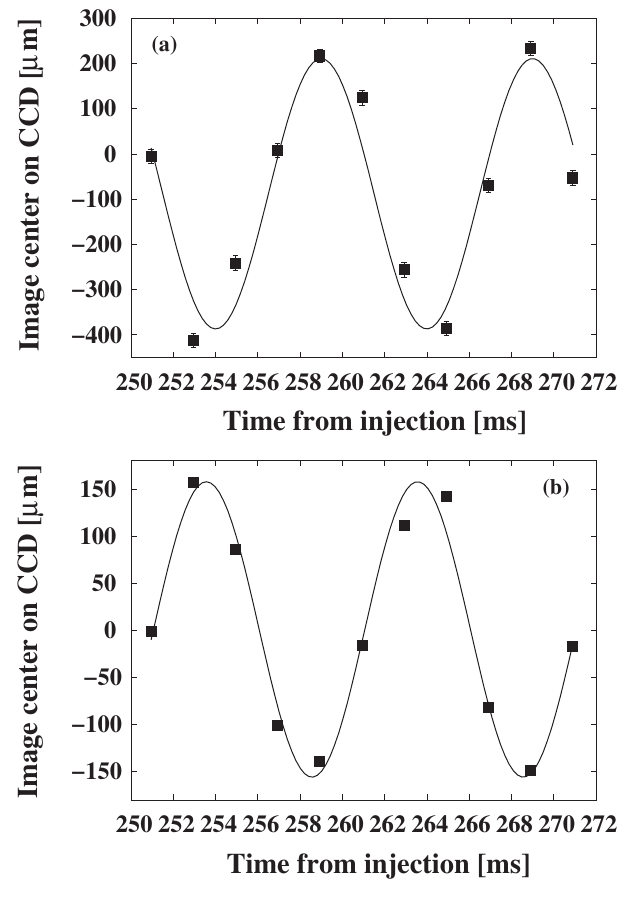
FIG. 13. Dependences of the measured (a) horizontal beam image center and (b) vertical beam image center corresponding to the shutter trigger time from beam injection when the shutter opening time was fixed to 1 ms. Data are from 2005 = 4 = 8 .